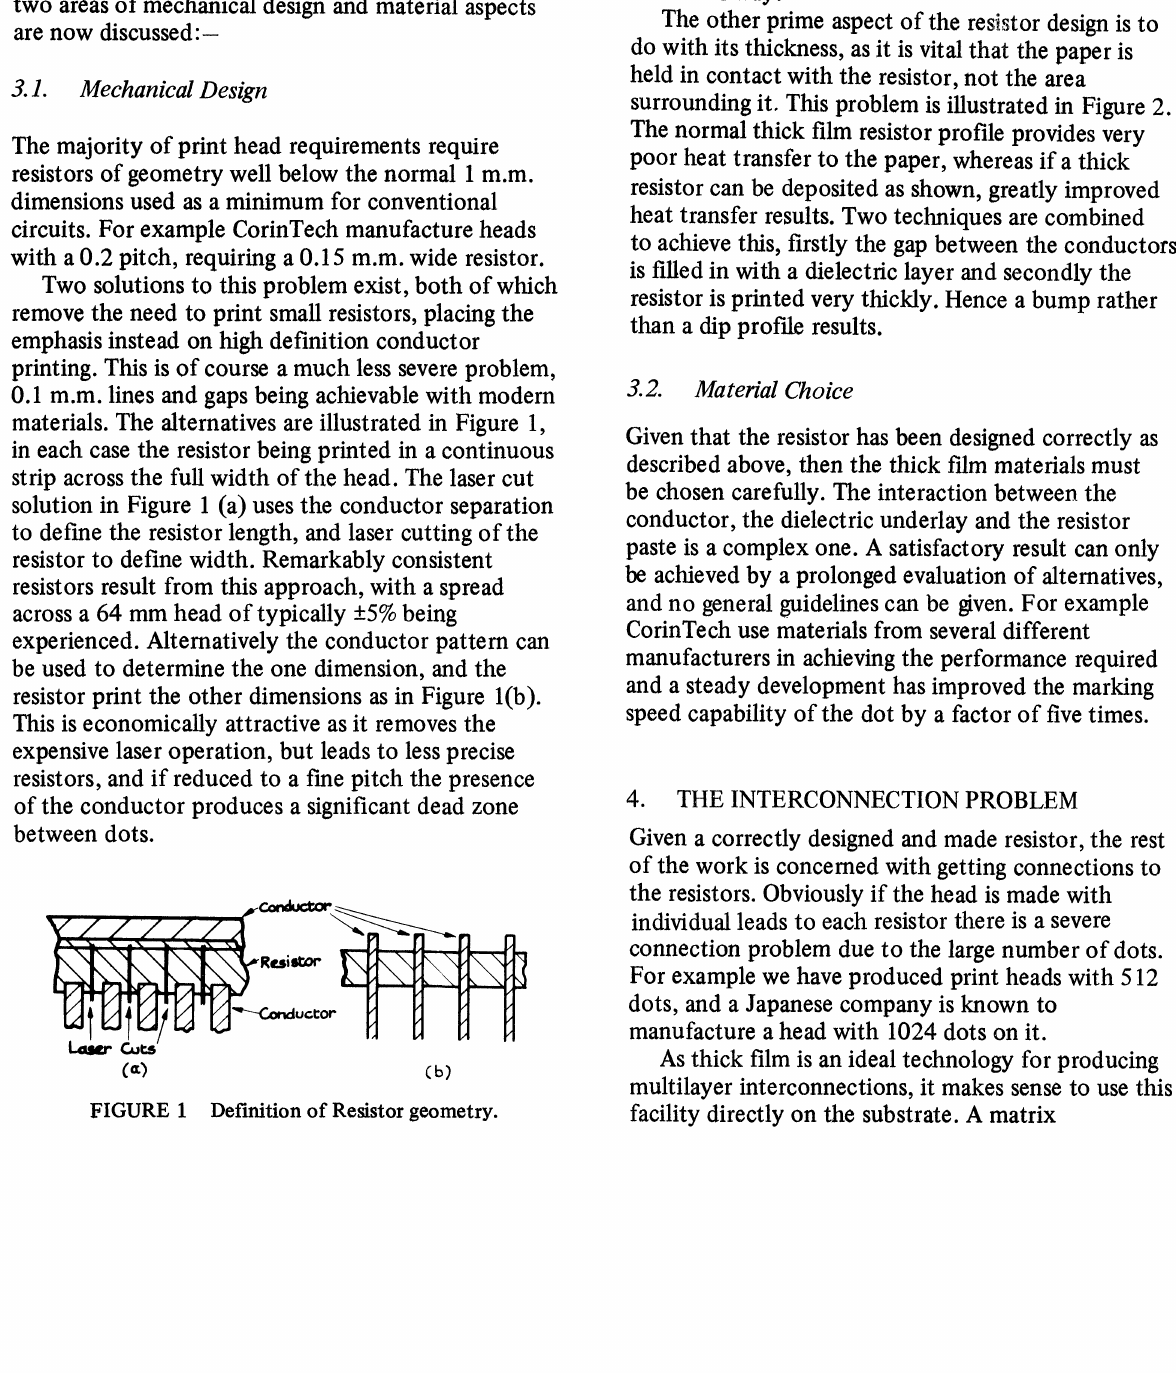
FIGURE 1 Definition of Resistor